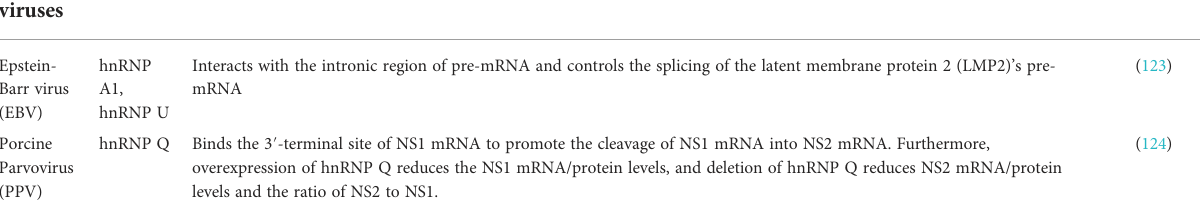
TABLE 3 hnRNPs involved in viral RNA splicing of different DNA viruses. DNA